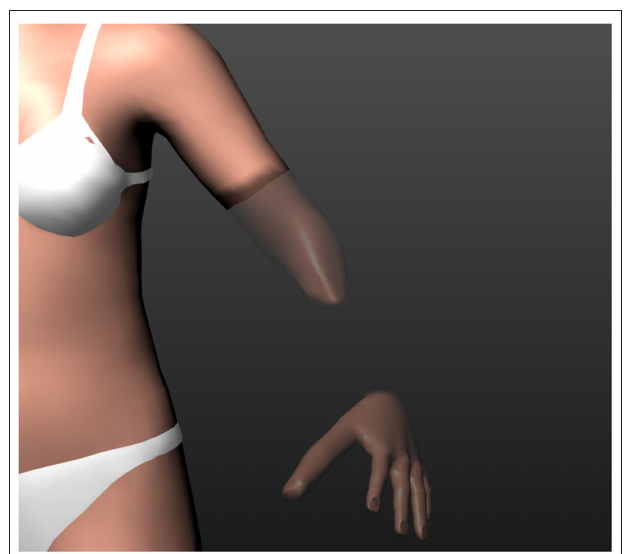
FIGURE 9 | A conceptual illustration of how to visualize the residual limb and phantom limb. The “presence” of the phantom limb is indicated by its visibility, meaning that the invisible parts are no longer perceived by the